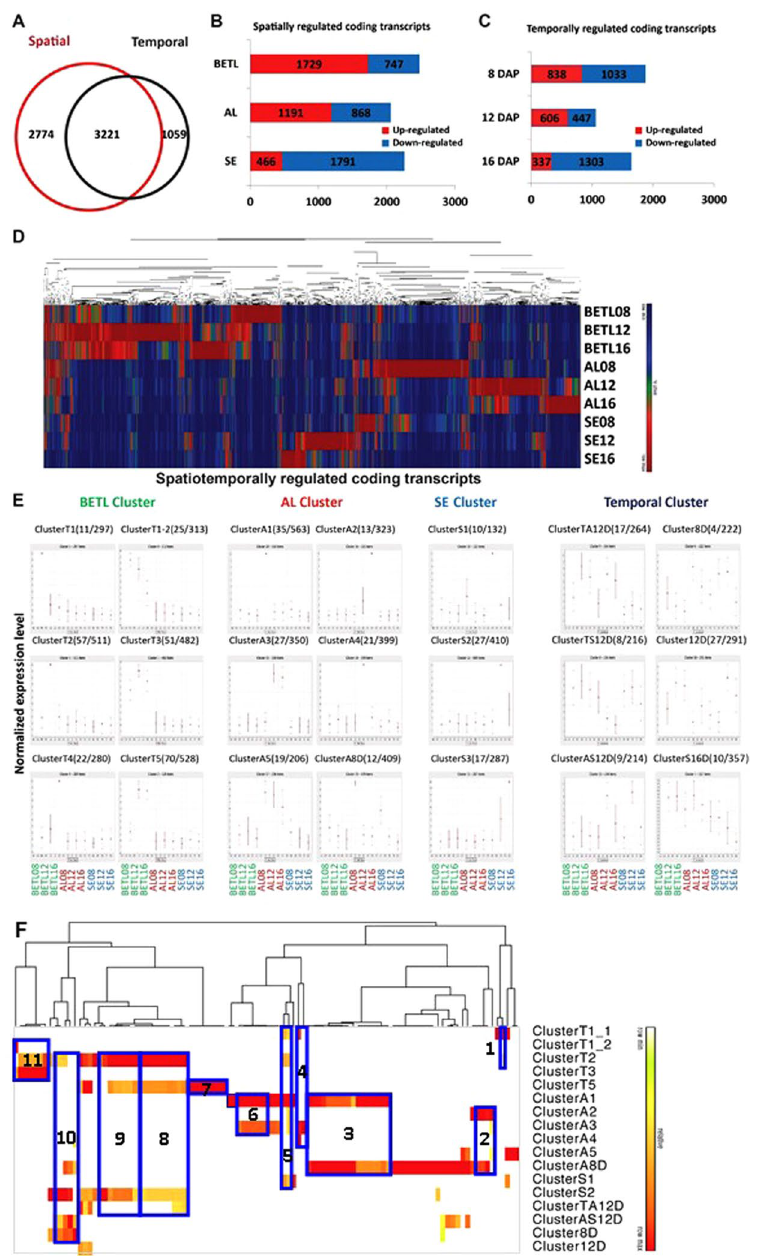
Figure 2. Differential expression of coding transcripts during endosperm development. ( A ) Coding transcripts with FPKM > 1.0 and with more than 4-fold expression-level changes were analysed; the overlap between spatially and temporally regulated are shown. ( B ) The numbers of coding transcripts that were up- or down- regulated more than 4 fold in any tissue are shown in box graphs. ( C ) The numbers of coding transcripts that were up- or down-regulated more than 4 fold at any DAP are shown in box graphs. ( D ) Hierarchical cluster analysis of spatio-temporally regulated coding transcripts. ( E ) SOM clusters are depicted based on clustering patterns. Given in parentheses is the number of co-expressed transcription factors and the number of genes that belong to each SOM cluster. The relative level of transcript is plotted on the y axis for each of nine samples: BETL08, BETL12, BETL16, AL08, AL12, AL16, SE08, SE12, and SE16 from left to right. ( F ) Functional GO-term enrichment. Significance is represented by heat map (-log 10 P-value; red – high/white – low). Representative functional categories correspond to numbers on graph as follows: 1, defence response; 2, oxoacid metabolic process (oxidation reduction); 3, macromolecular complex subunit organization (chromatin assembly or disassembly, nucleosome assembly, protein-DNA packing); 4, lipid biosynthesis processes; 5, response to stimulus and stress; 6, response to abiotic stimulus and biotic stress (temperature); 7, microtubule- based process; 8, post translational process (phosphorylation, protein modifications); 9, regulation of metabolic/ biosynthesis process; 10, regulation of transcription process; 10, macromolecule biosynthesis process; 11, establishment of